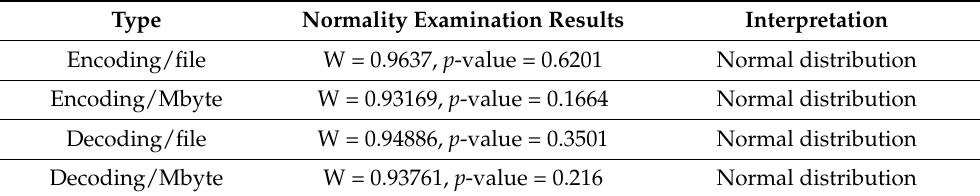
Table 11. Shapiro-Wilk Normality test (R-Studio 1.3).